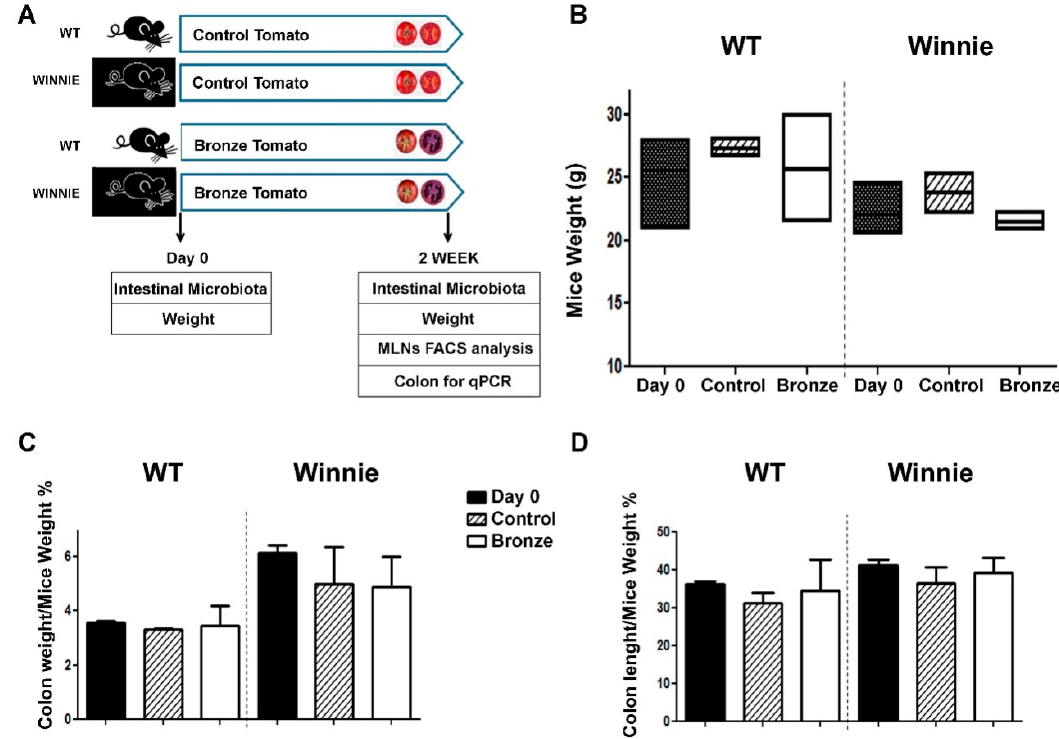
Figure 1. Experimental design and macroscopic characterization of the experimental groups. ( A ) Sex-matched mice were divided into four groups based on their genotype (Wild Type or Winnie) and their diet (enriched with Control or Bronze lyophilized tomato fruit). Mouse weight was recorded at the beginning of diet administration (Day 0) and at the end of the trial (2 Weeks). Fecal samples were collected for microbial meta-analyses at both time points (Day 0 and Week 2). Tissues were explanted and analyzed at the end of the treatments as indicated. Analysis of mice from different groups included: mouse weight ( B ), colon weight/mouse weight ( C ) and colon length/mouse weight ( D ). Black bars show the values at Day 0, striped bars show the Control- and white bars the Bronze-enriched diet. Statistical evaluation was performed using unpaired two-tailed Student’s t -tests.